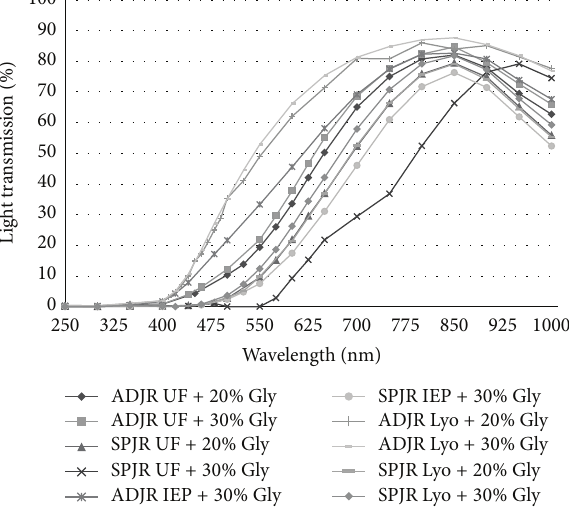
Figure 6: Light transmission of Jatropha -based cast